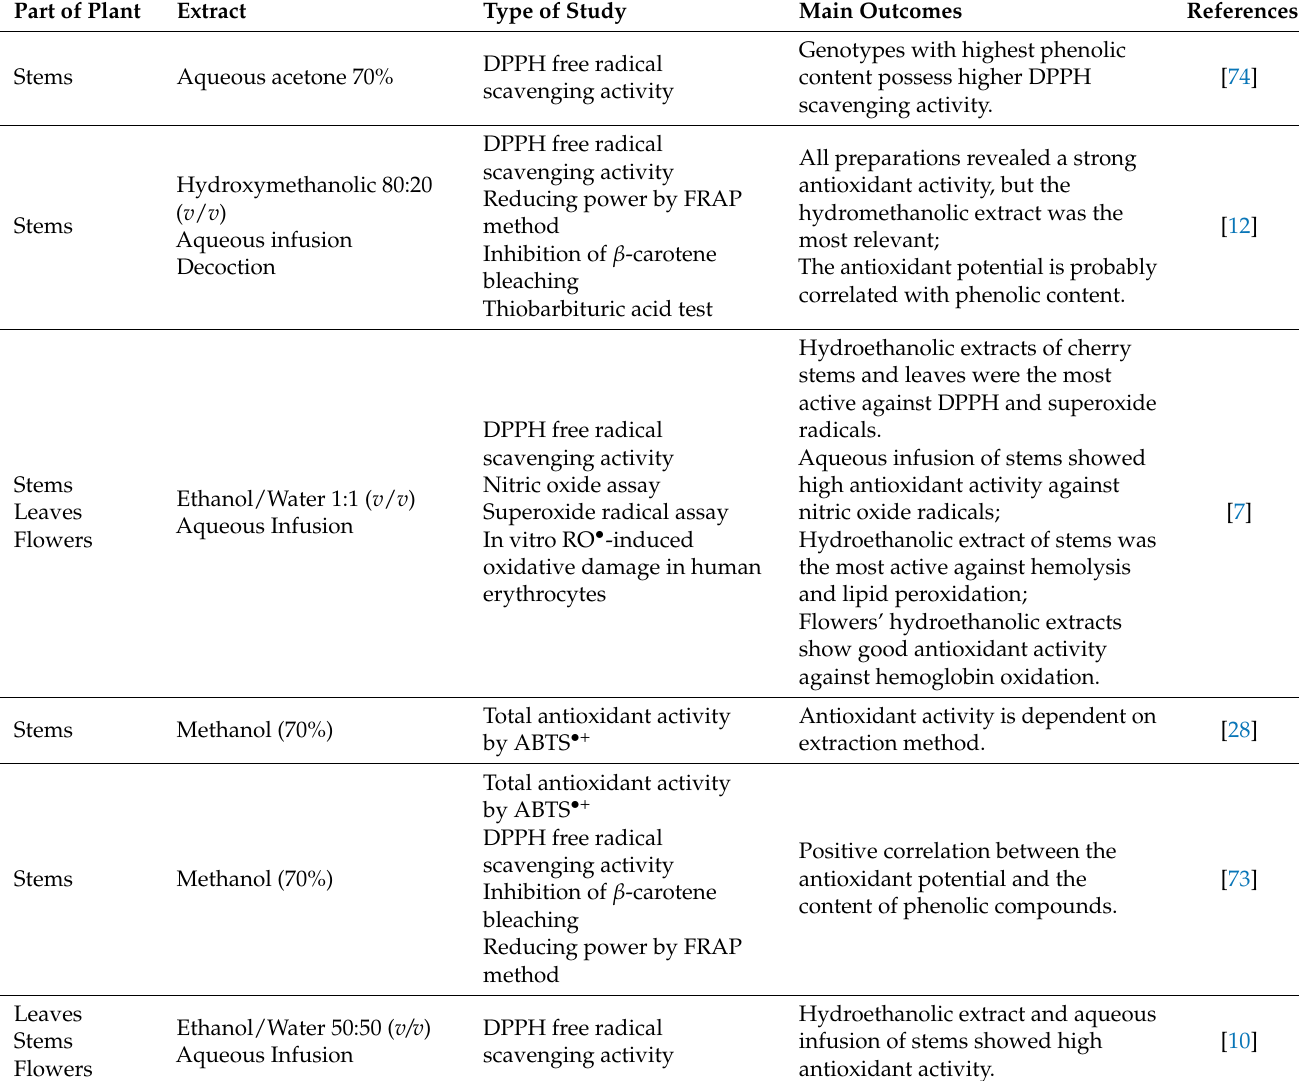
Table 4. Antioxidant activity of Prunus avium L.